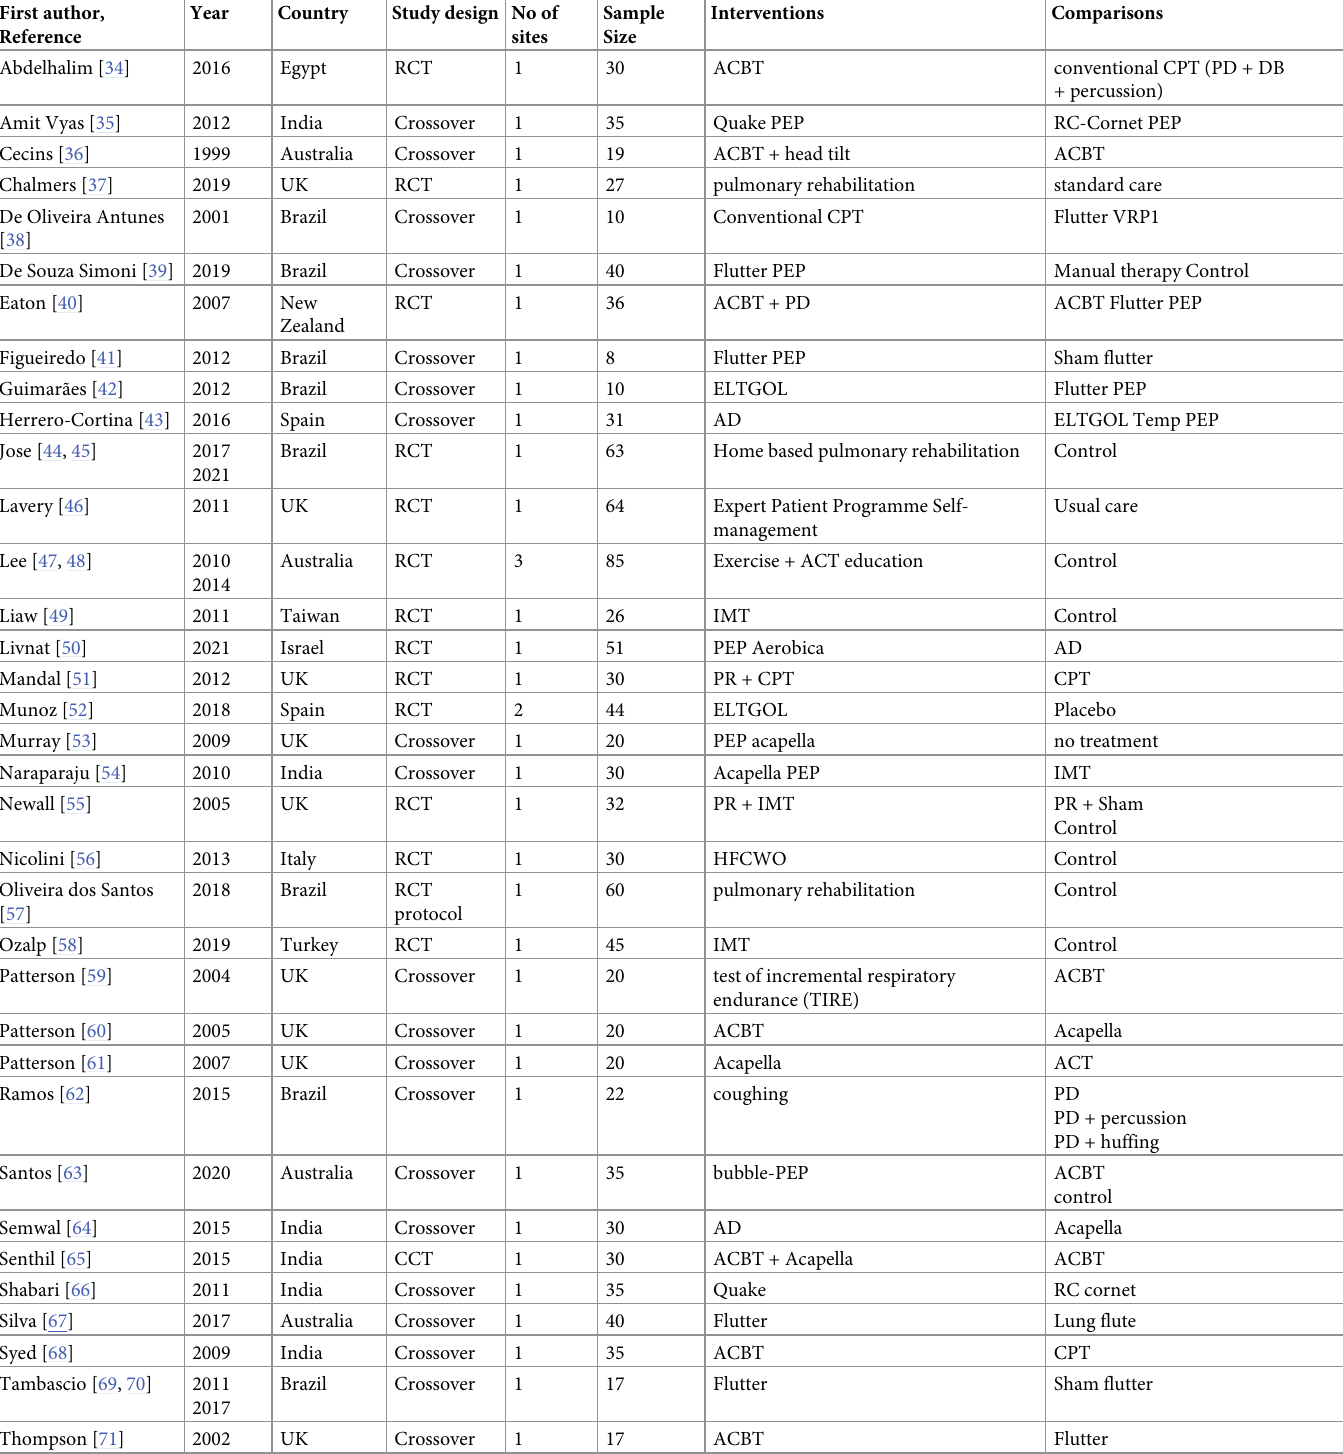
Table 2. Characteristics of included